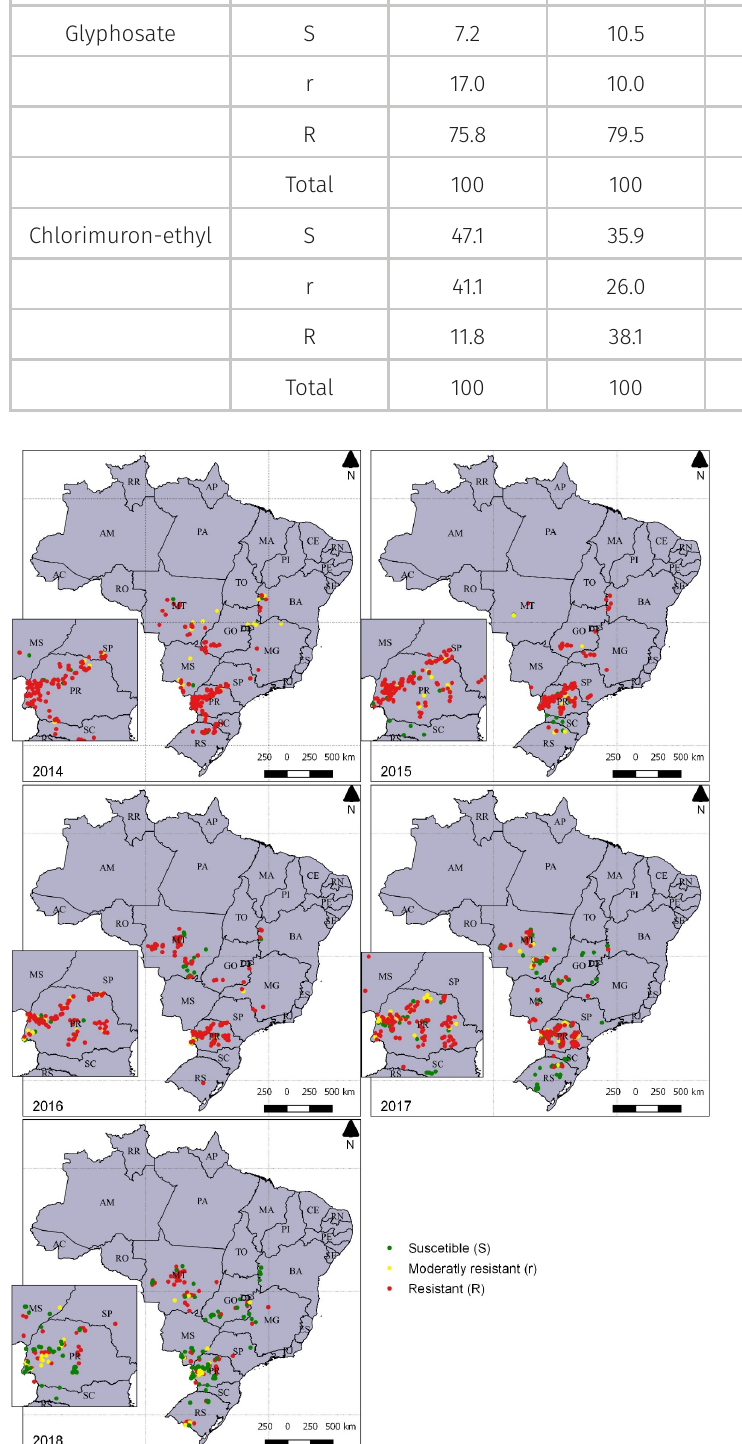
Table II. Frequency (%) of Conyza spp. populations classified as susceptible (S), moderately resistant (r), and resistant (R) to glyphosate and chlorimuron-ethyl in Brazil. Herbicide Class 2014 2015 2016 2017 2018 Glyphosate